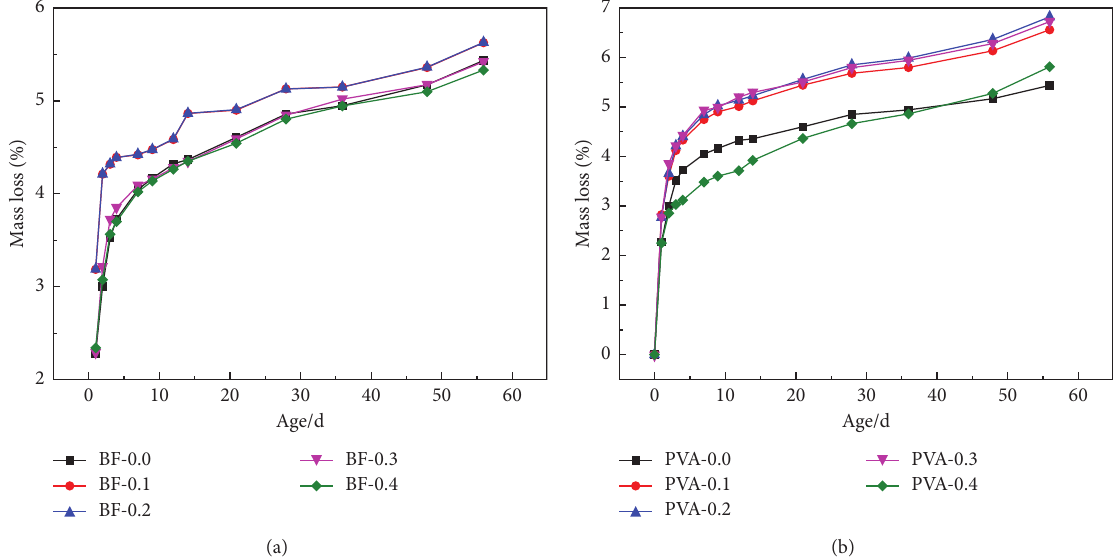
Figure 5: Effect of content of (a) basalt fibres and (b) PVA fibres on water loss rate of geopolymer mortars.